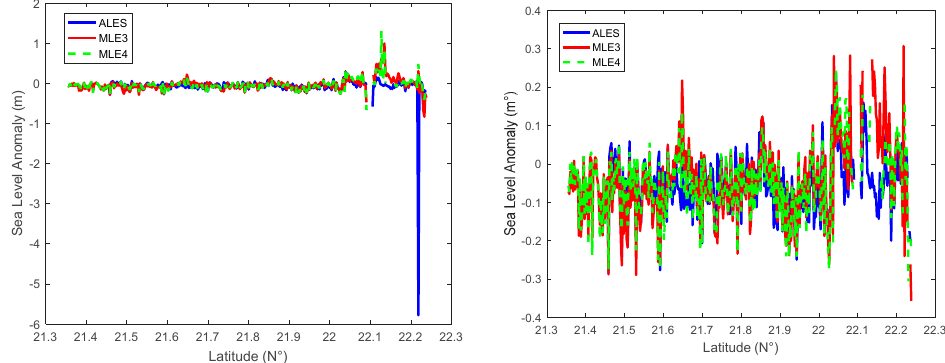
Figure 6. 20-Hz sea level anomaly (SLA) before ( left ) and after ( right ) editing. Jason-2 cycle 5 is considered here.